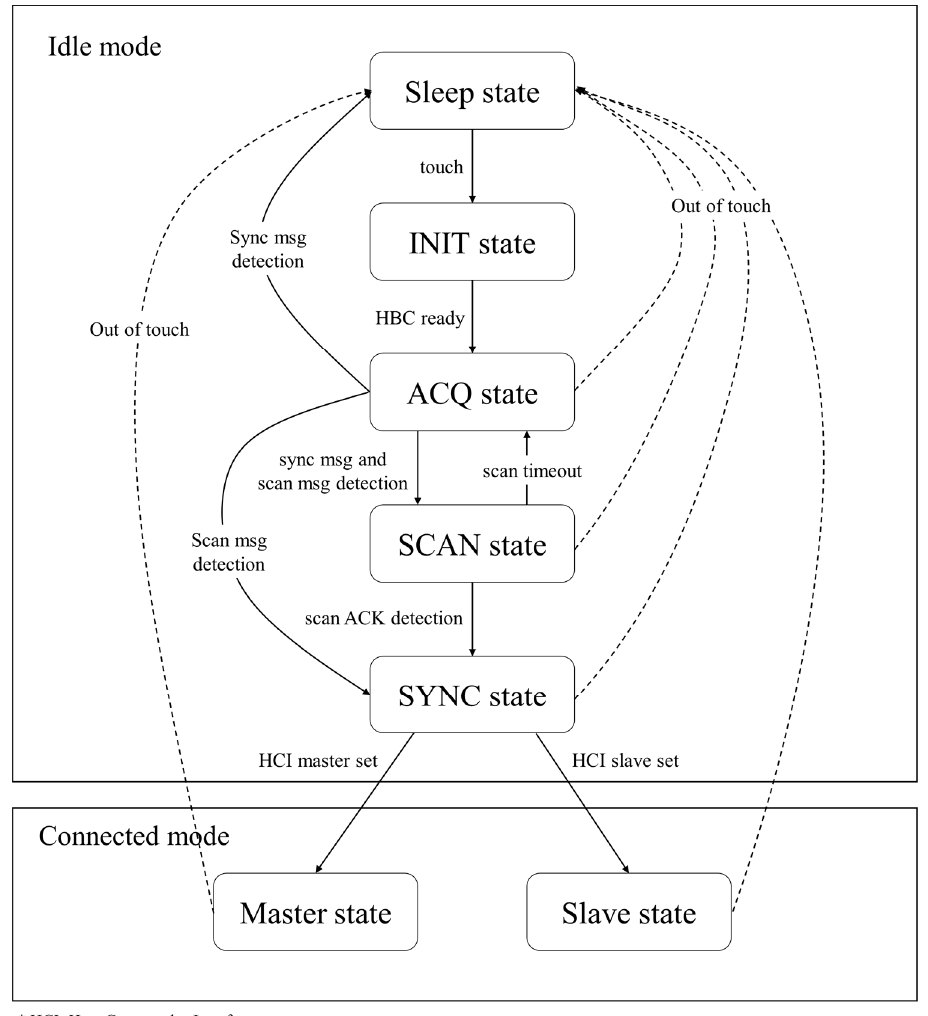
Figure 4. Network layer state diagram.